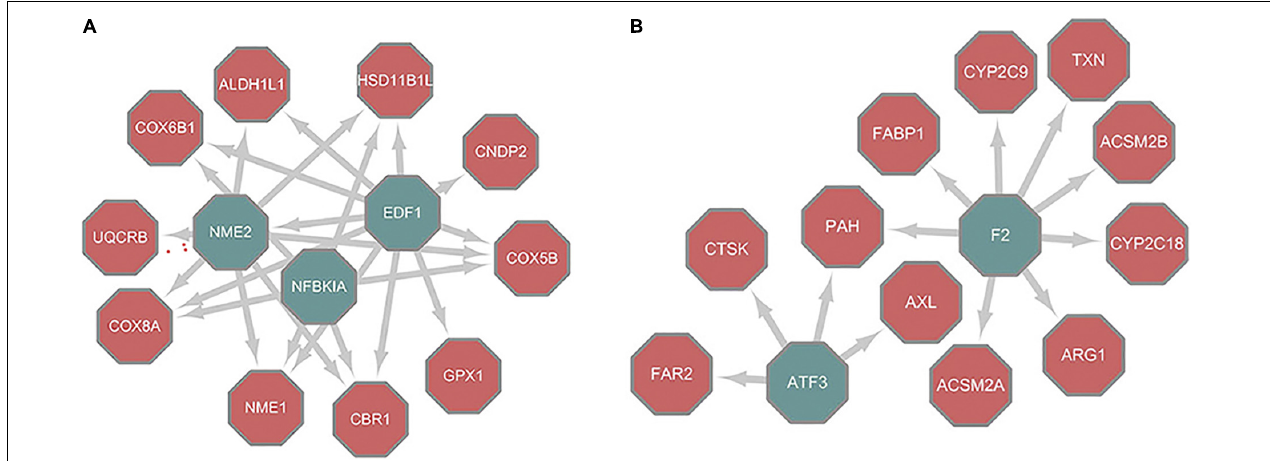
FIGURE 2 | Core structure of different nodes between topology of normal/tumor regulatory networks. (A) Differences between normal and tumor networks. (B) Differences between tumor and normal networks; Nodes filled with green are TFs while nodes filled with red are metabolic genes.